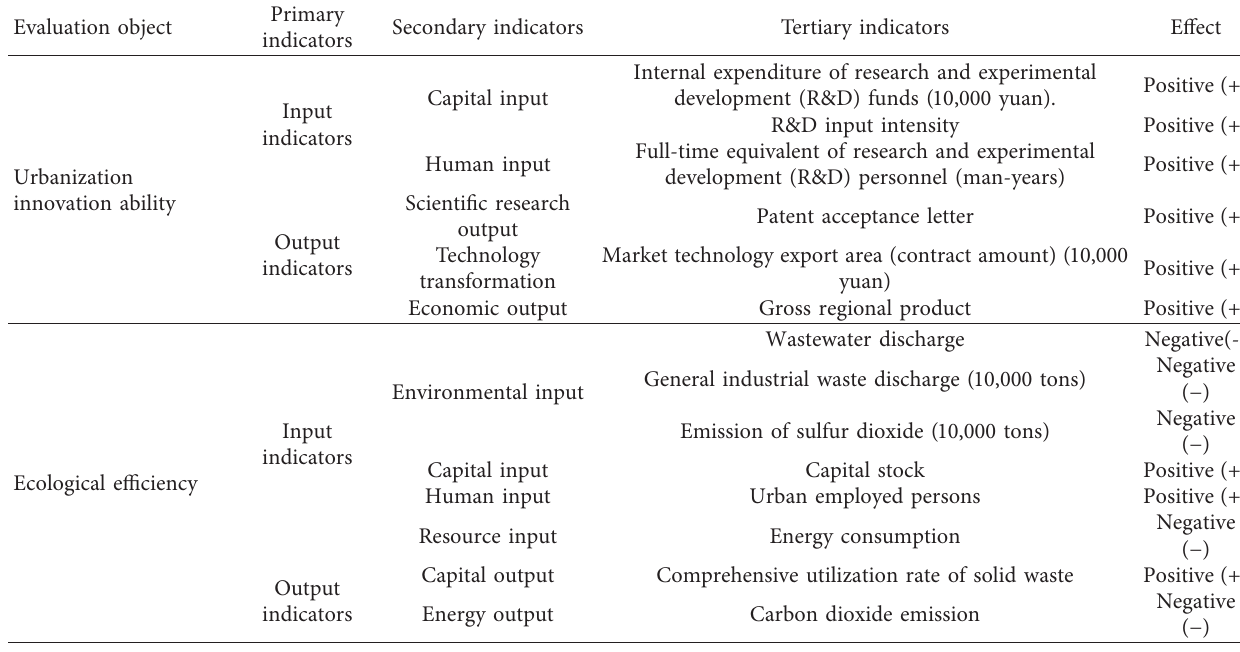
Table 1: Urban innovation level and ecological efficiency index